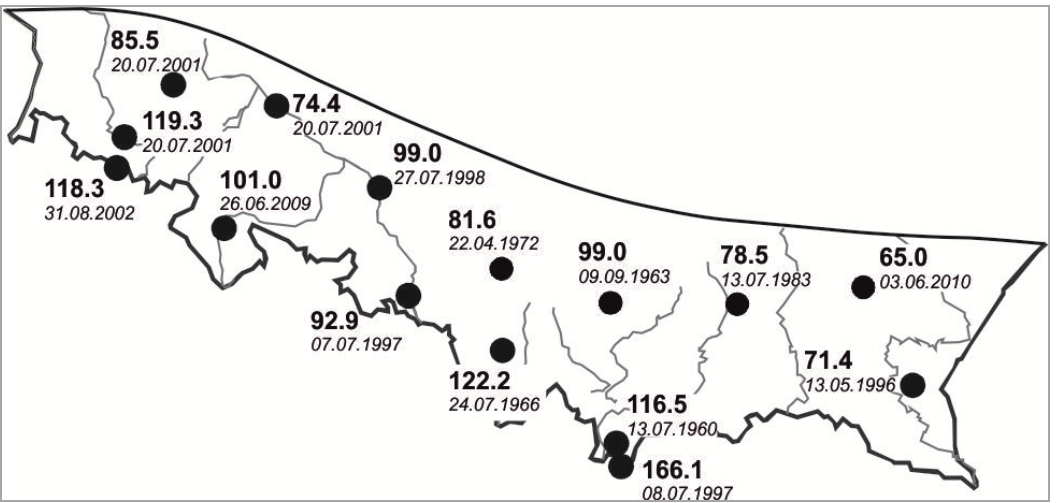
Fig. 6. The highest precipitation [mm] on the days with thunderstorm in the period